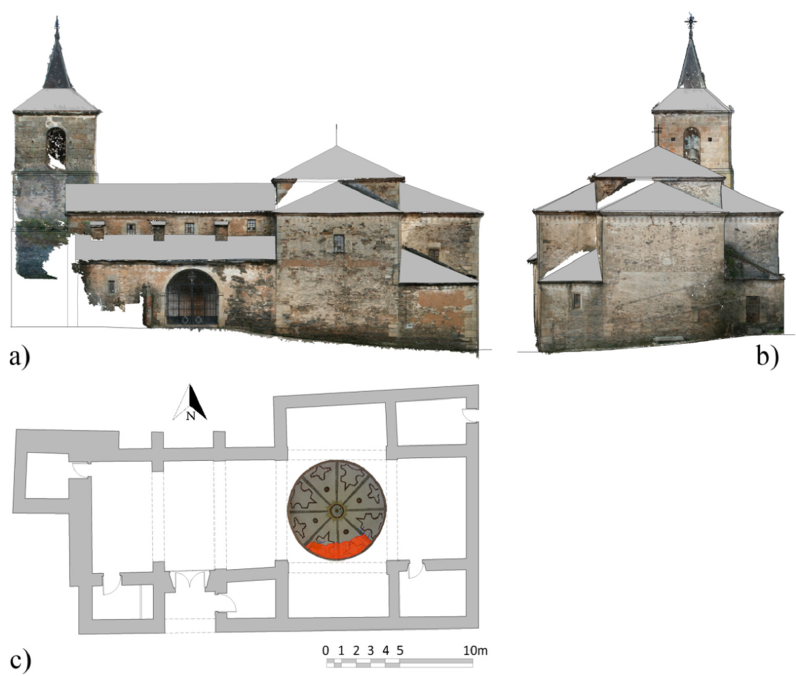
Figure 5. San Lorenzo church: ( a ) Orthophoto of the main façade through the methodology proposed; ( b ) Orthophoto of the west façade (chancel) of the construction; ( c ) Floor plan-view of the church, red color indicates the damaged area of the dome.